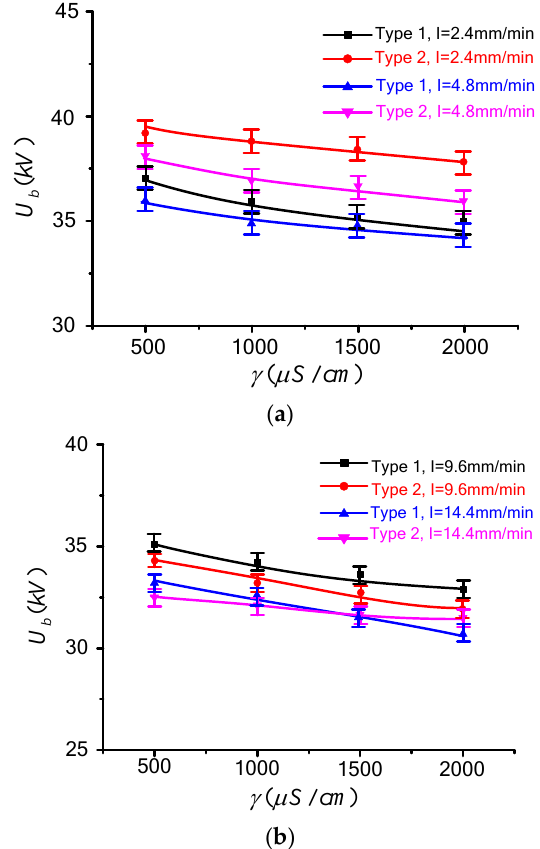
Figure 3. Effects of rain conductivity on flashover voltage: ( a ) I = 2.4, 4.8 mm/min ( b ) I = 9.6, 14.4 mm/min.